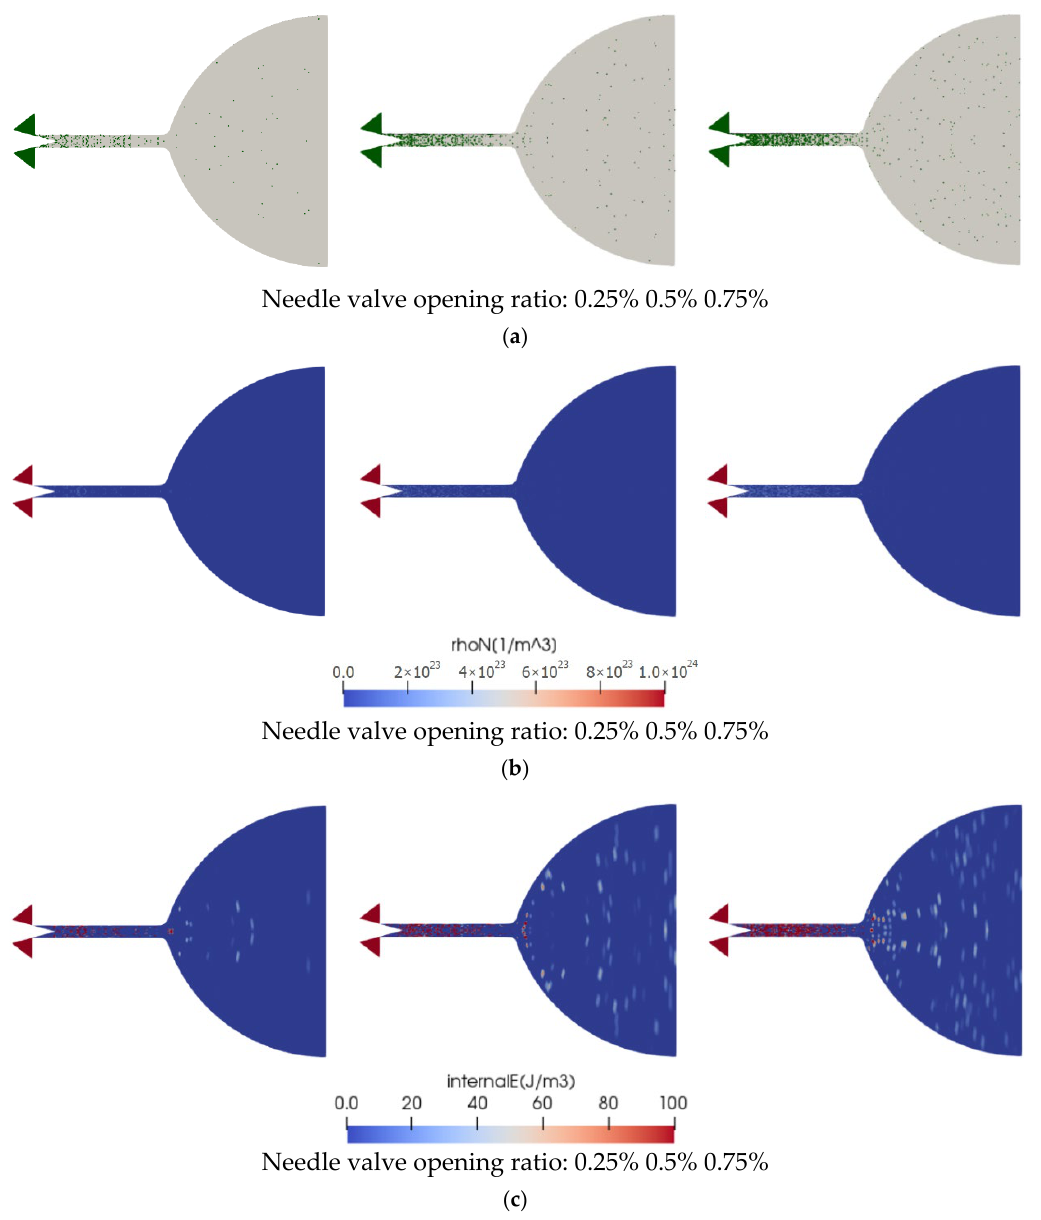
Figure 12. Molecular particle position, molecular number density, and internal energy distributions in the axial plane with different valve openings at t = 0.1 ms. ( a ) Molecular Particles. ( b ) Molecular number density. ( c ) Internal energy of molecule.